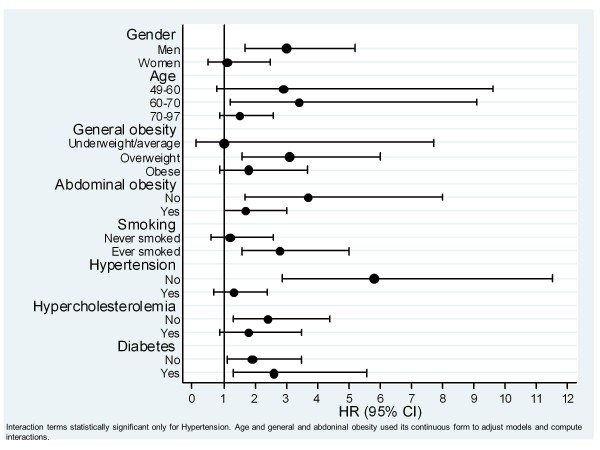
Effect of peripheral arterial disease for coronary disease, measured by hazard ratio (HR), among different potential cardiovascular risk factors.